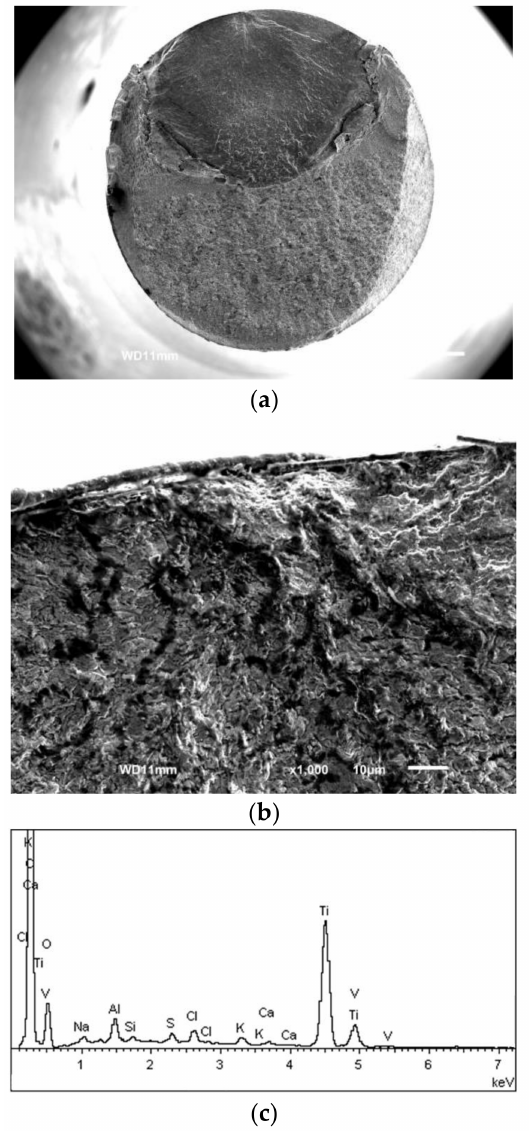
Figure 12. Fracture surface of TC4 (UNSM-TiN-SBF, 660 MPa, 1.81 × 10 6 cycles): ( a ) Overall view of fracture surface; ( b ) Crack initiation; ( c ) EDX analysis of crack